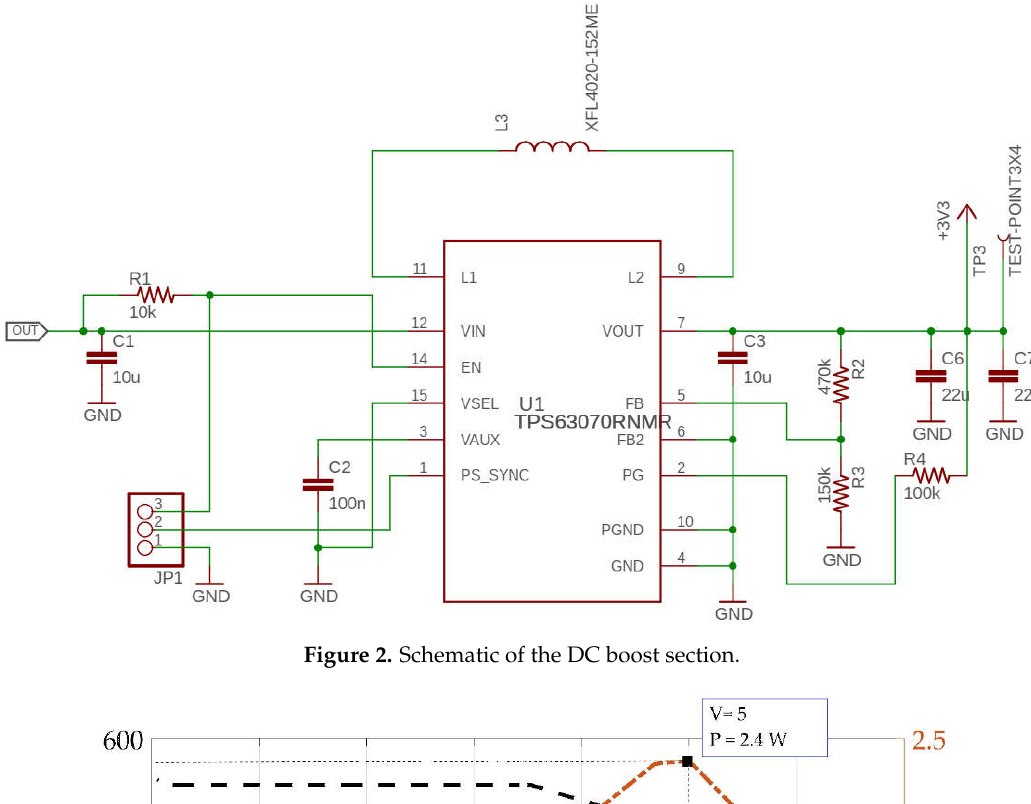
Figure 2. Schematic of the DC boost section.